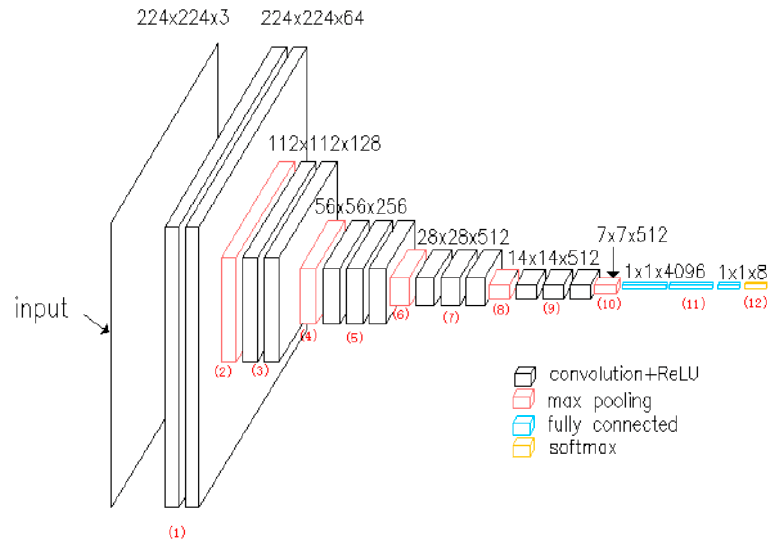
Figure 3. Diagram of VGG network.